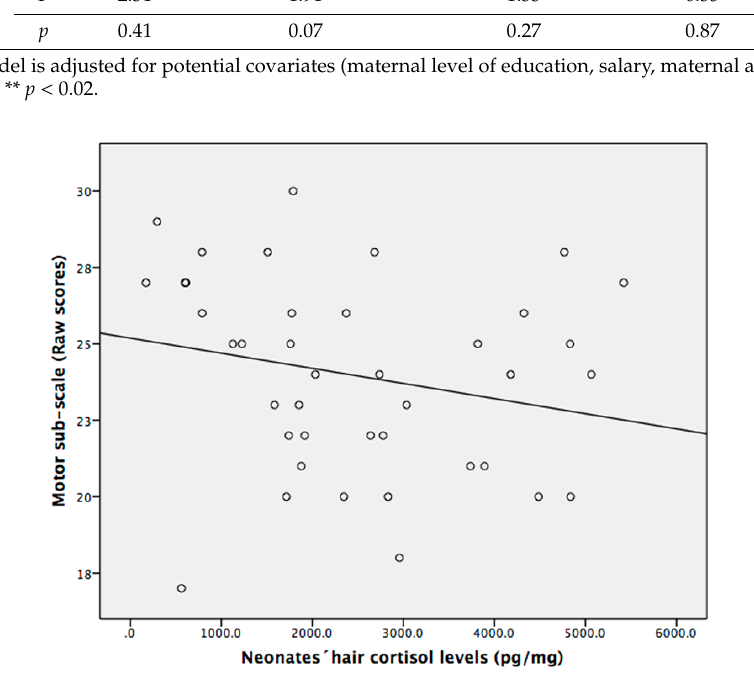
Table 5. Summary of the hierarchical regression models using maternal and neonatal hair cortisol levels as predictors of infant neurodevelopment at six months of age.